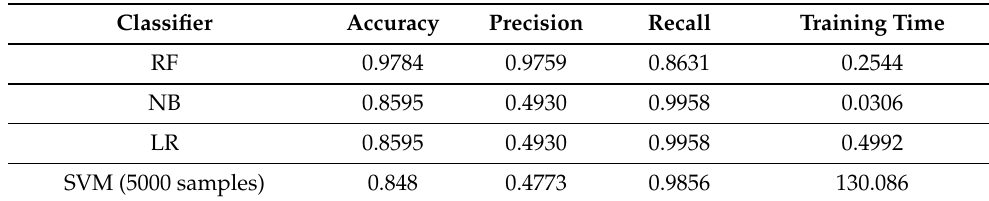
Table 6. Comparison of various machine learning models for detection rates.